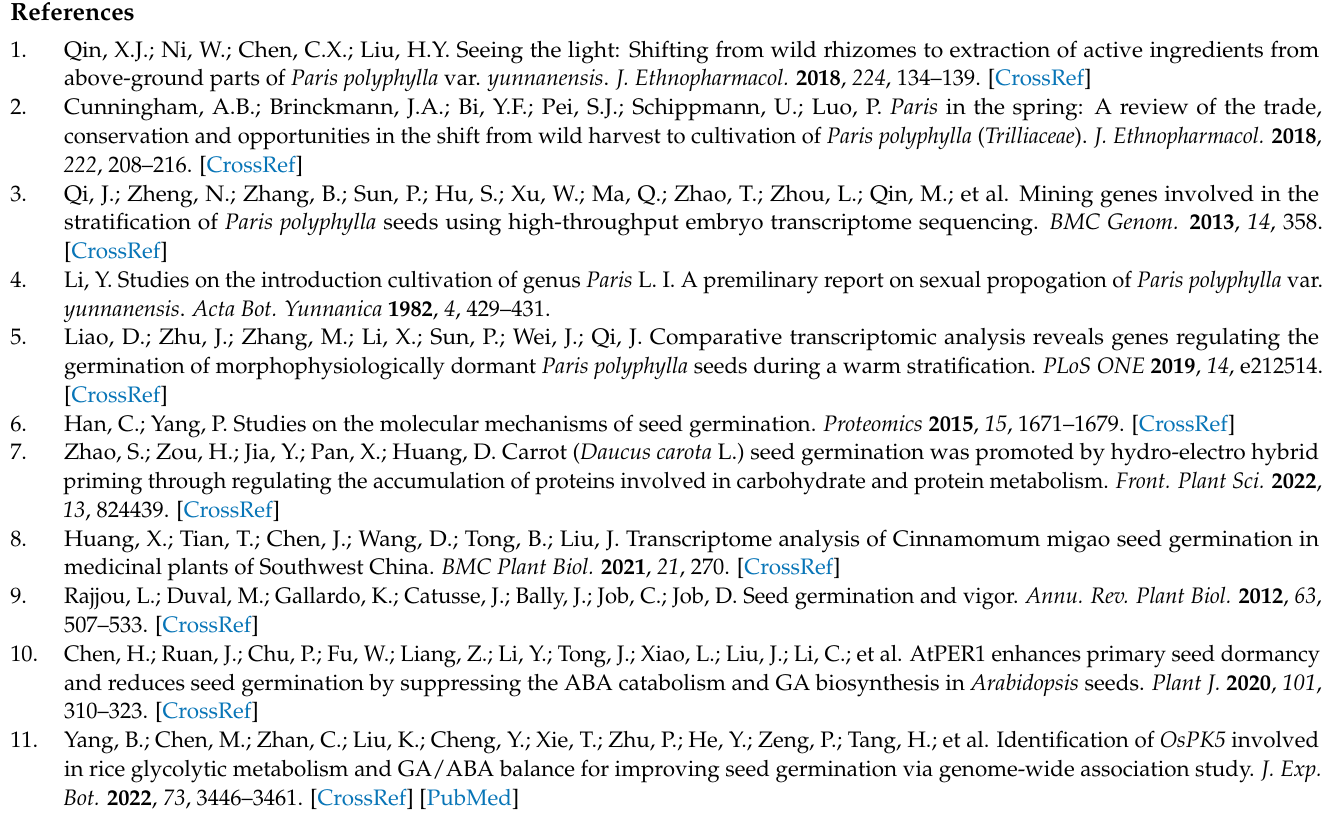
Table S3: Differentially expressed genes related to lipid metabolism; Table S4: Differentially expressed genes related to signal transduction; Table S5: Differentially expressed genes related to translation; Table S6: List of primer pairs used in this